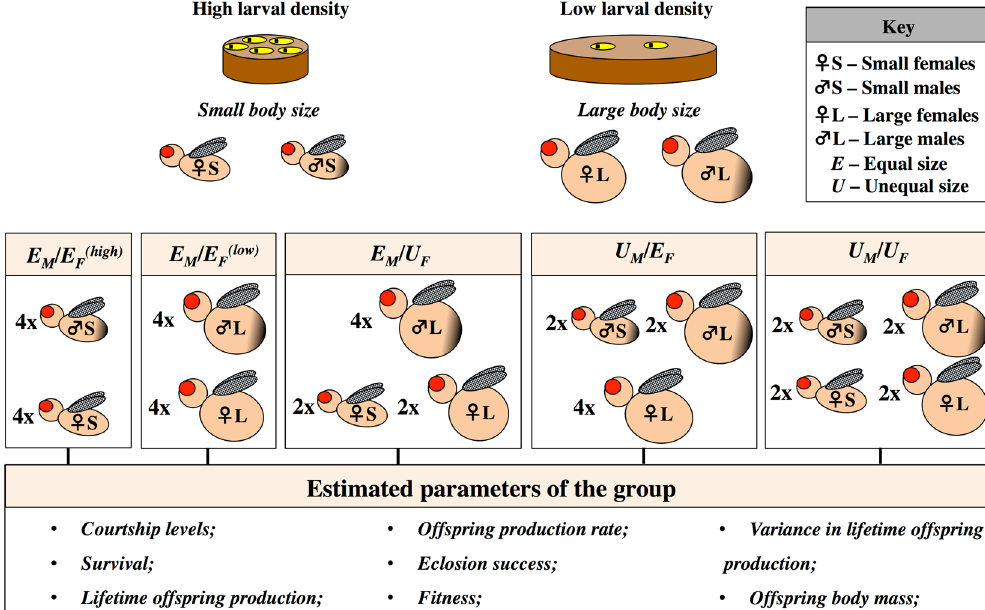
Figure 1. Summary of the experimental design. We manipulated larval density to obtain males and females of large and small body size. We then set up groups composed of individuals with different combinations of body size. E M / E F(high) – groups where all individuals experienced high larval density; E M / E F(low) – groups where all individuals experienced low larval density; E M /U F – groups where all males were phenotypically equal, reared at low density and females had mixed phenotypes; U M /E F – groups where all females were phenotypically equal, reared at low density, and males had mixed phenotypes; U M /U F – groups where both males and females had mixed